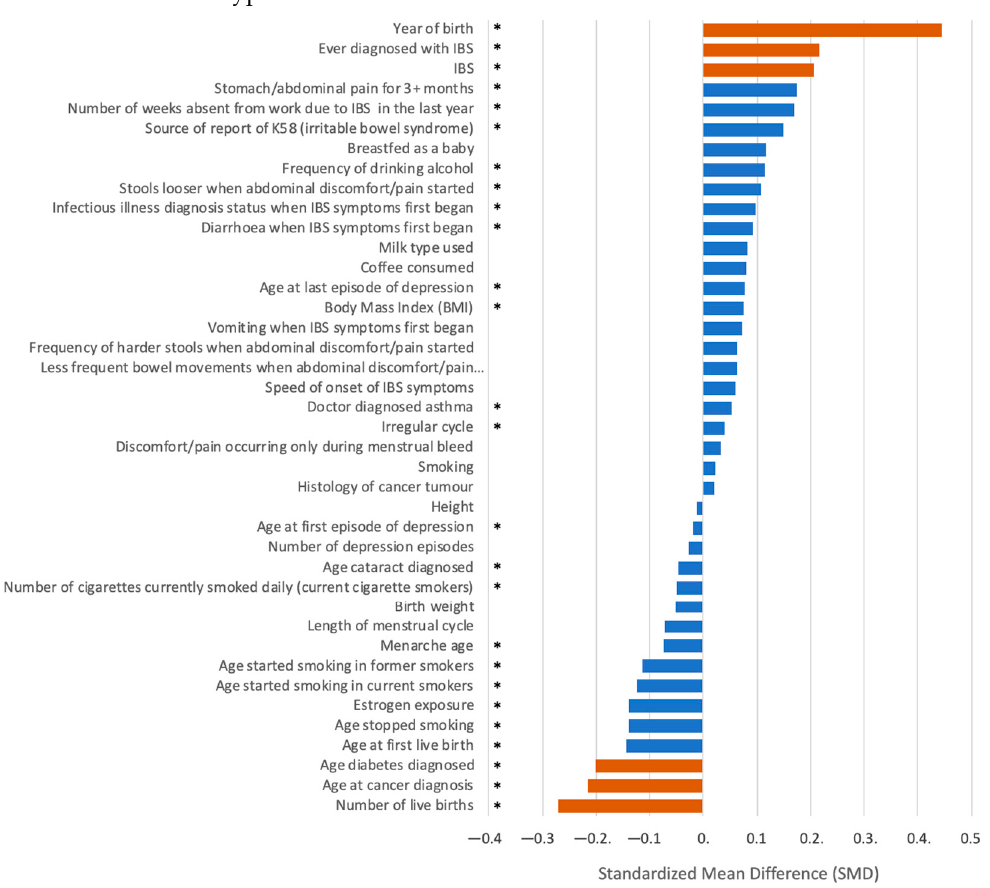
Figure 1. Univariate analysis for endometriosis. A ranked list of attributes (total of 44) associated with endometriosis diagnosis and control groups by the standardized mean difference (SMD). SMD values < − 0.2 and >0.2 are colored orange to indicate those with a substantial effect size. The statistics were based on the median calculated for the Q1–Q3 values. An asterisk (*) next to the description of the attribute is the case with a p -value <0.05 for univariate tests of cases and controls (see Methods). For a univariate statistical test and results, see Supplementary Table S1.